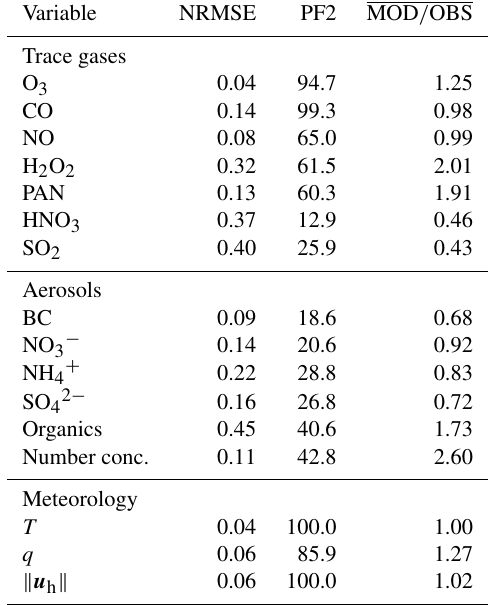
Table 1. Summary of model–observation comparison. The same spatiotemporal location was used for all simultaneously avail- able points. NRMSE is the root-mean-squared error normalized by the range of the observations. PF2 denotes the percentage of model points within a factor of 2 of the observations. The column MOD / OBS is the average of the simulated and observed data